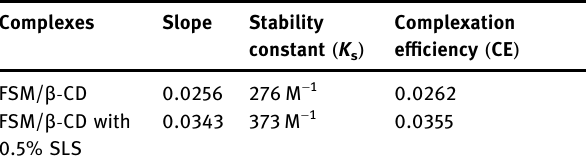
Table 1: Complexation parameters of FSM/ β - CD and FSM/ β - CD with SLS